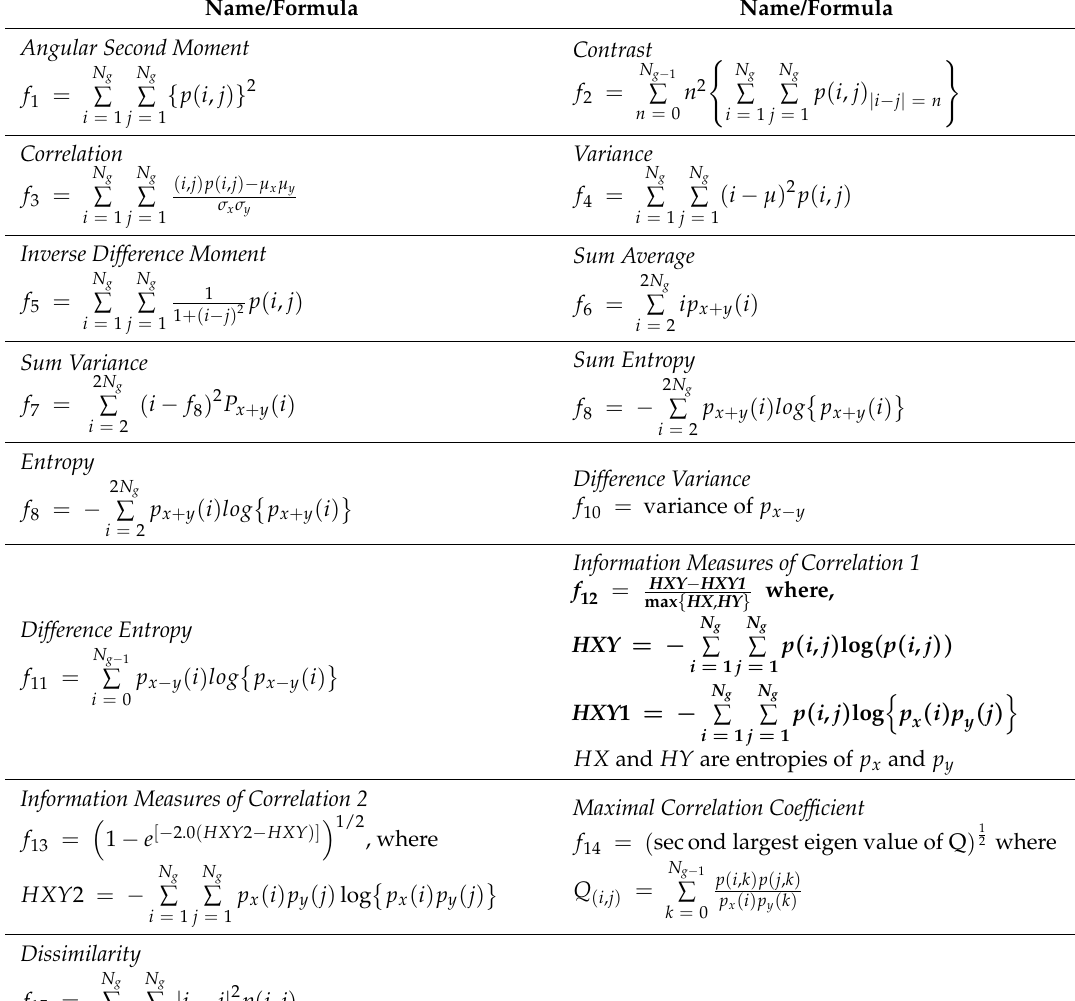
Table A1. Textural feature formulas from Gray Level Co-occurrence Matrix, as described in [51].